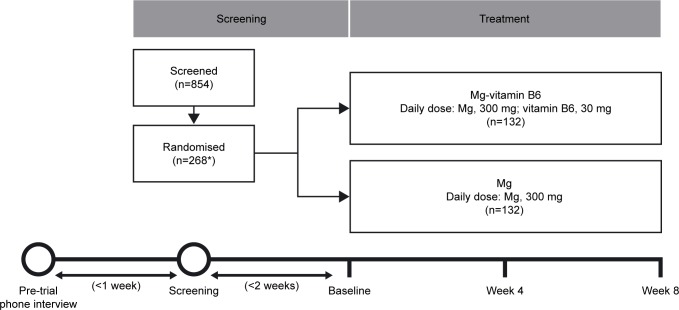
Trial design.*Four subjects did not proceed to the treatment phase and did not receive any investigational product due to major protocol deviations. Mg, magnesium.